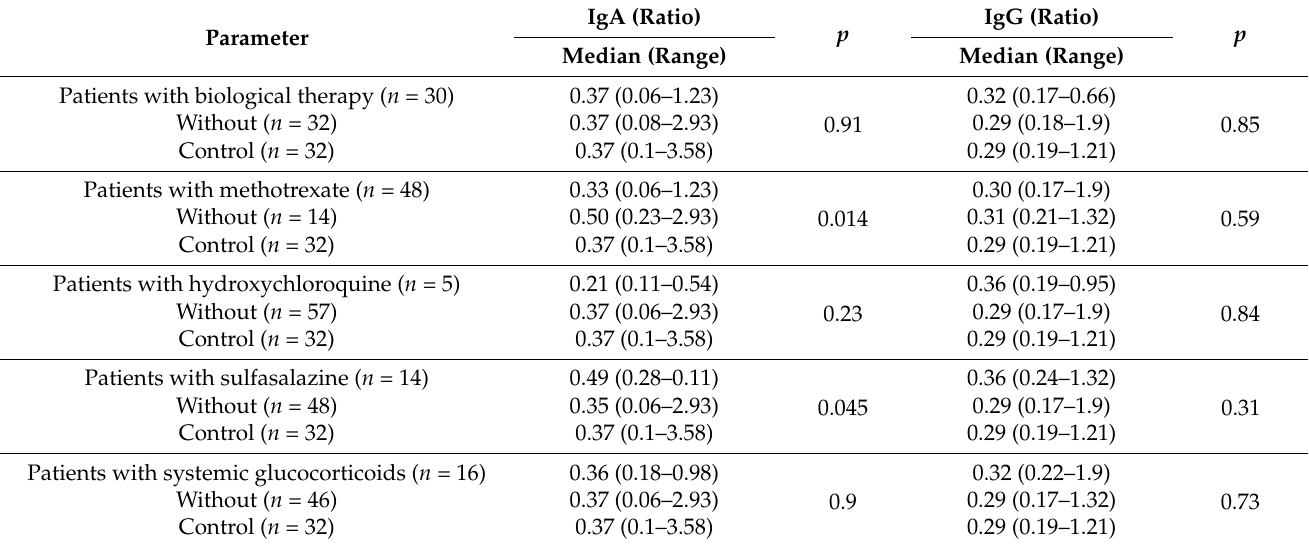
Table 4. Anti-SARS-CoV-2 (IgA, IgG) levels in JIA patients according to therapy type.